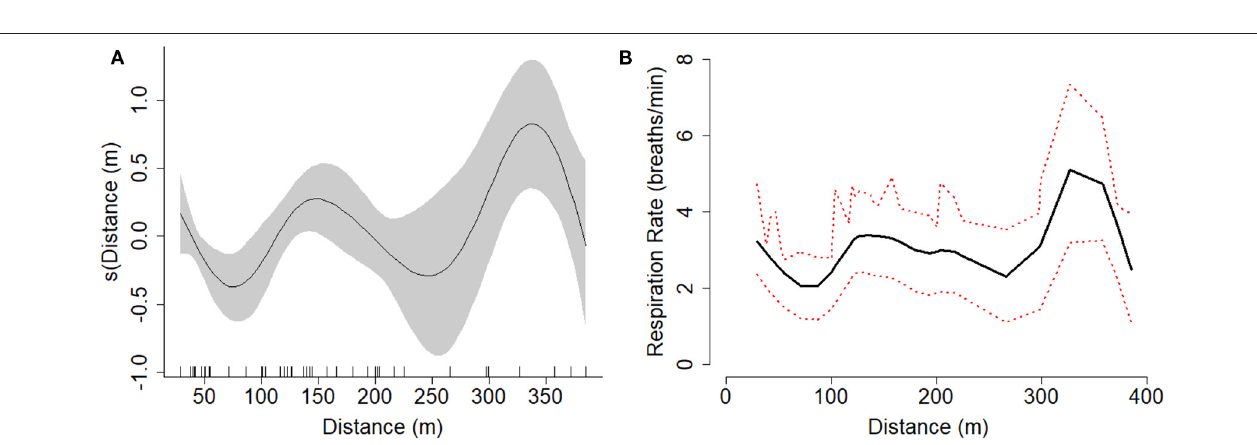
FIGURE 6 | Results from the best fit generalized additive model (GAM) for humpback whale dive time showing group (A) model parameter estimates for vessel approach type (No Vessel: no vessels within 500m; Additional Guidelines: vessels(s) were approaching under additional voluntary guidelines; Regulations: vessel(s) were assumed approaching under federal regulations only; Mix: multiple vessels approaching with one or more following additional voluntary guidelines and one or more following federal guidelines only) and (B) model predicted dive times based upon vessel approach type. Dashed lines in image (A) represent the 95% confidence intervals of the parameter estimate, and vertical ticks indicate the locations of observations (i.e., a rugplot).